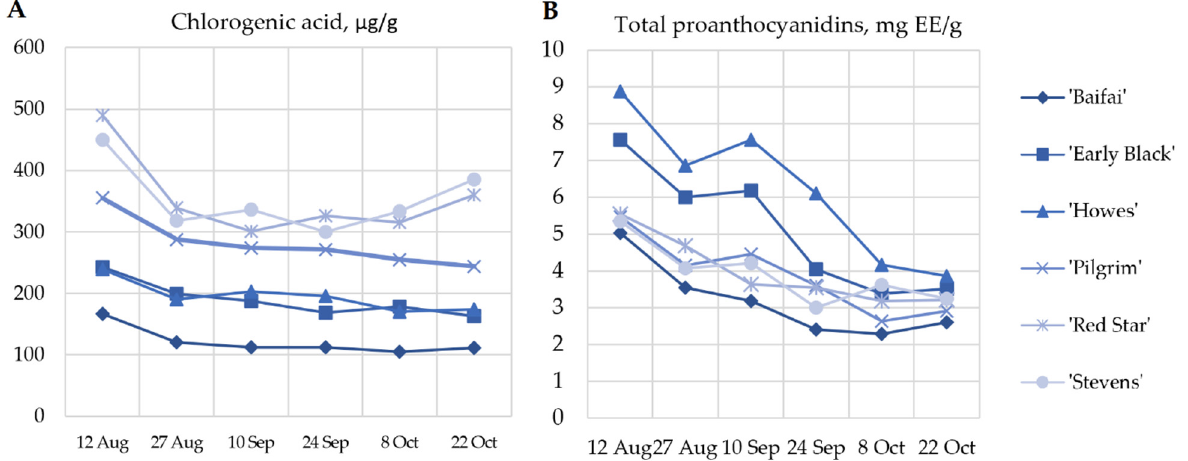
Figure 4. ( A ) Variability of the quantitative composition of chlorogenic acid in fruit samples of large cranberry cultivars during ripening. ( B ) Variability of the content of proanthocyanidins in large cranberry samples during ripening.